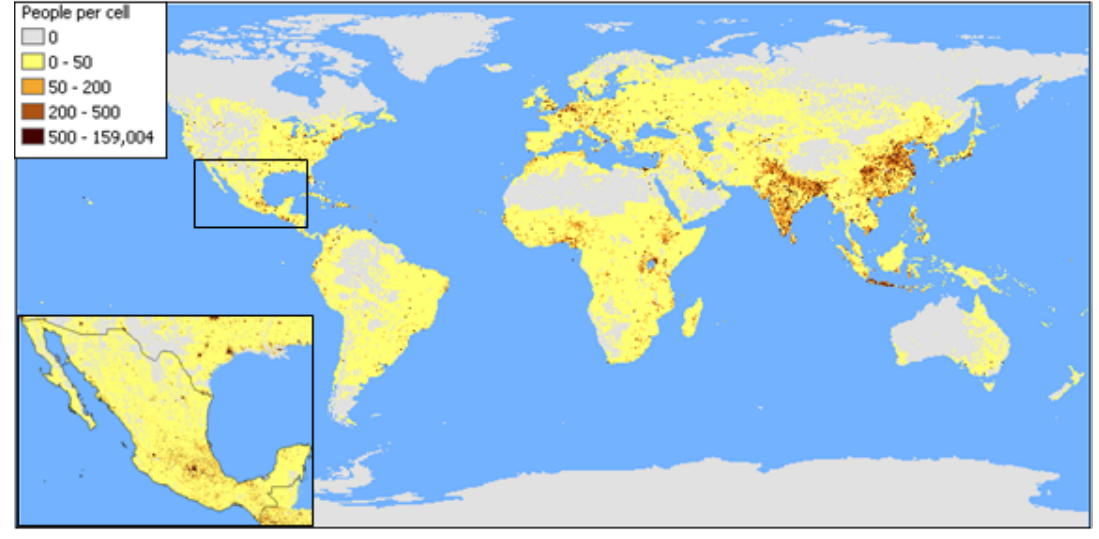
Figure 2. Landscan Population Data, 2000, Mexico in the